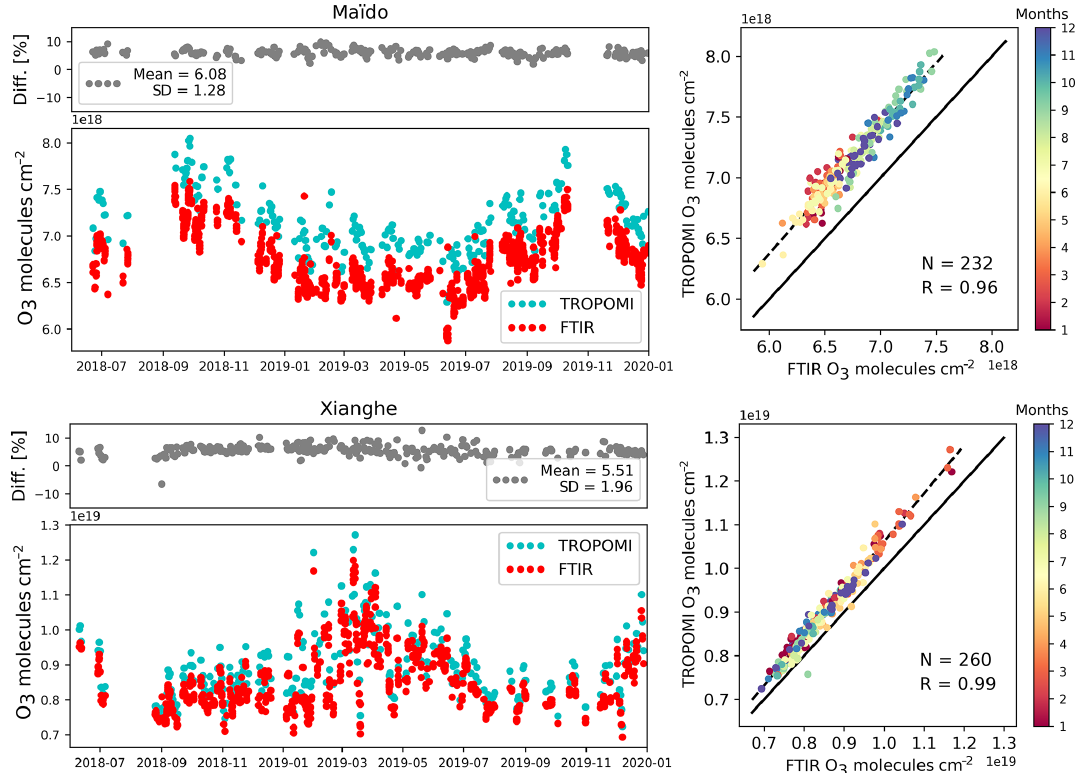
Figure 5. The time series of the co-located total columns from FTIR and TROPOMI measurements, together with their relative differences ( ( FTIR − TROPOMI )/ TROPOMI × 100%) and their correlations at Maïdo and Xianghe between June 2018 and December 2019. N is the co-located number of data pairs and R is the correlation coefficient. The correlation dots are colored with their measurement months. The dashed black line is the linear regression